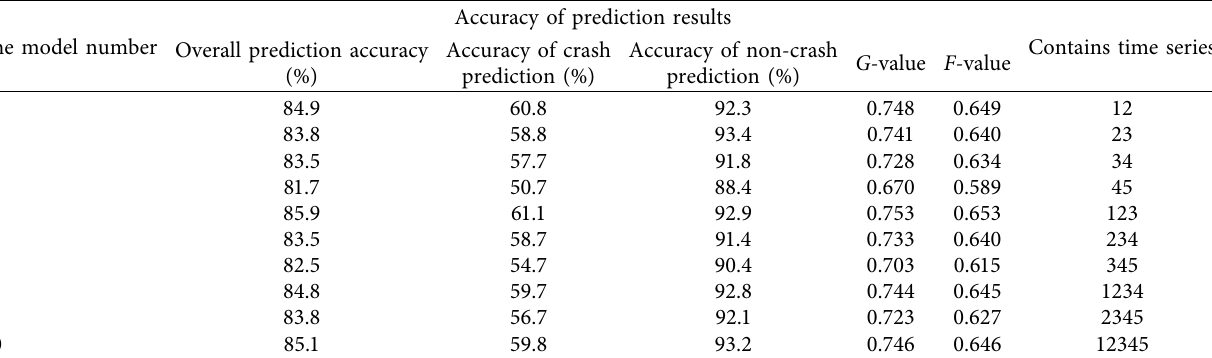
Table 5: Prediction results of dynamic Bayesian network model considering diferent time series. Accuracy of prediction Te model number